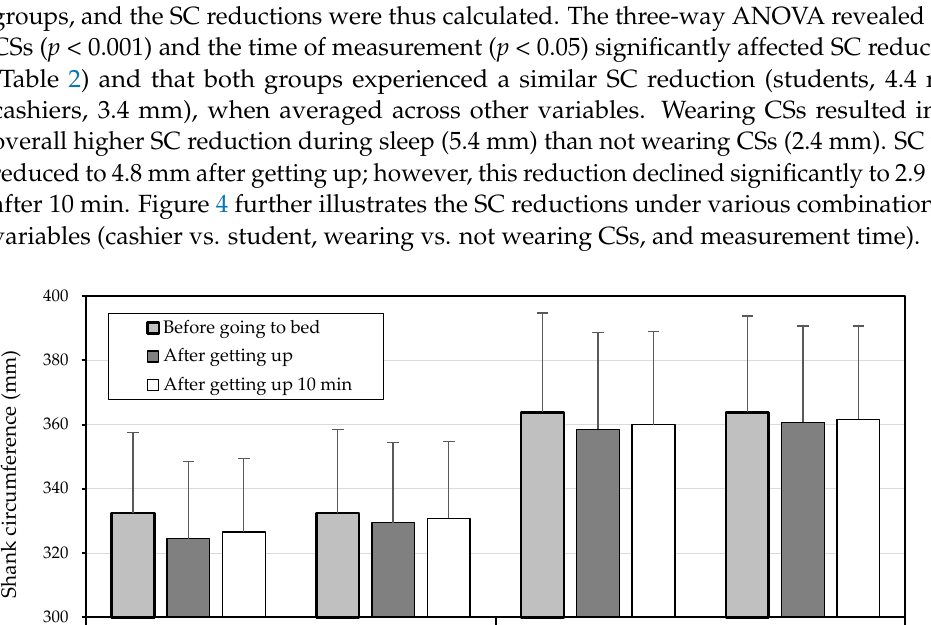
0.050 Figure 4. Effects of compression stockings (CSs) and measurement time on shank circumference re- duction between groups. The dotted line indicates the baseline obtained after getting out of bed without CSs. 3.3. Discomfort and Tightness Results Table 3 reveals the results of the VAS assessments across both sessions. The differ- ences between the two sessions were examined using an independent or paired t test. The results indicated that the cashiers (score: 4.8) experienced higher levels of leg discomfort than the students (score: 2.9) before going to bed ( p < 0.05). After getting up the next morn- ing, no significant differences in tightness attributed to wearing CSs were recorded. How- ever, tightness attributed to wearing CSs for both the students and the cashiers was rela- tively high, with scores of 4.2 and 5.1, respectively. Only the students who did not wear